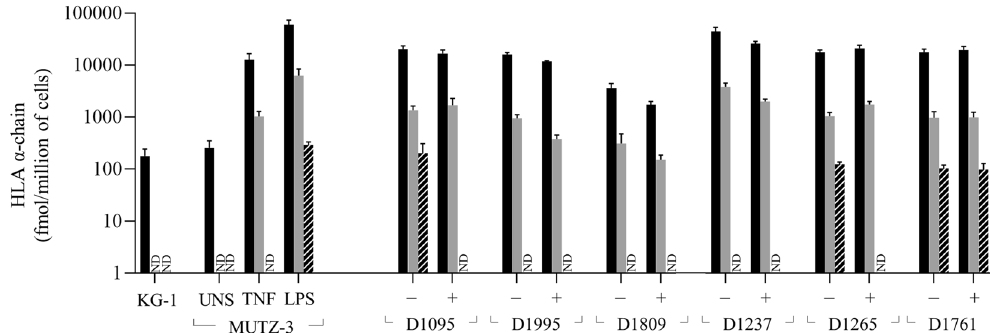
Figure 5. Amount of HLAII α-protein per million dendritic-like cells and DCs before (−) and after (+) LPS activation. Quantification of endogenous HLA-DRA1/DQA2 (Black bars), -DPA1 (Gray bars) and -DQA1 (Striped bars) based on the normalization with the signal of stable isotope labeled (SIL) peptides. Total amount of each HLA chain was back calculated by multiplying the normalized endogenous signal by the amount of SIL used. Each bar represents the mean and the SD of three samples corresponding to 25,000, 50,000 and 100,000 cells, each of them injected in duplicate and previously averaged. UNS, Unstimulated cells; ND, Peptide not